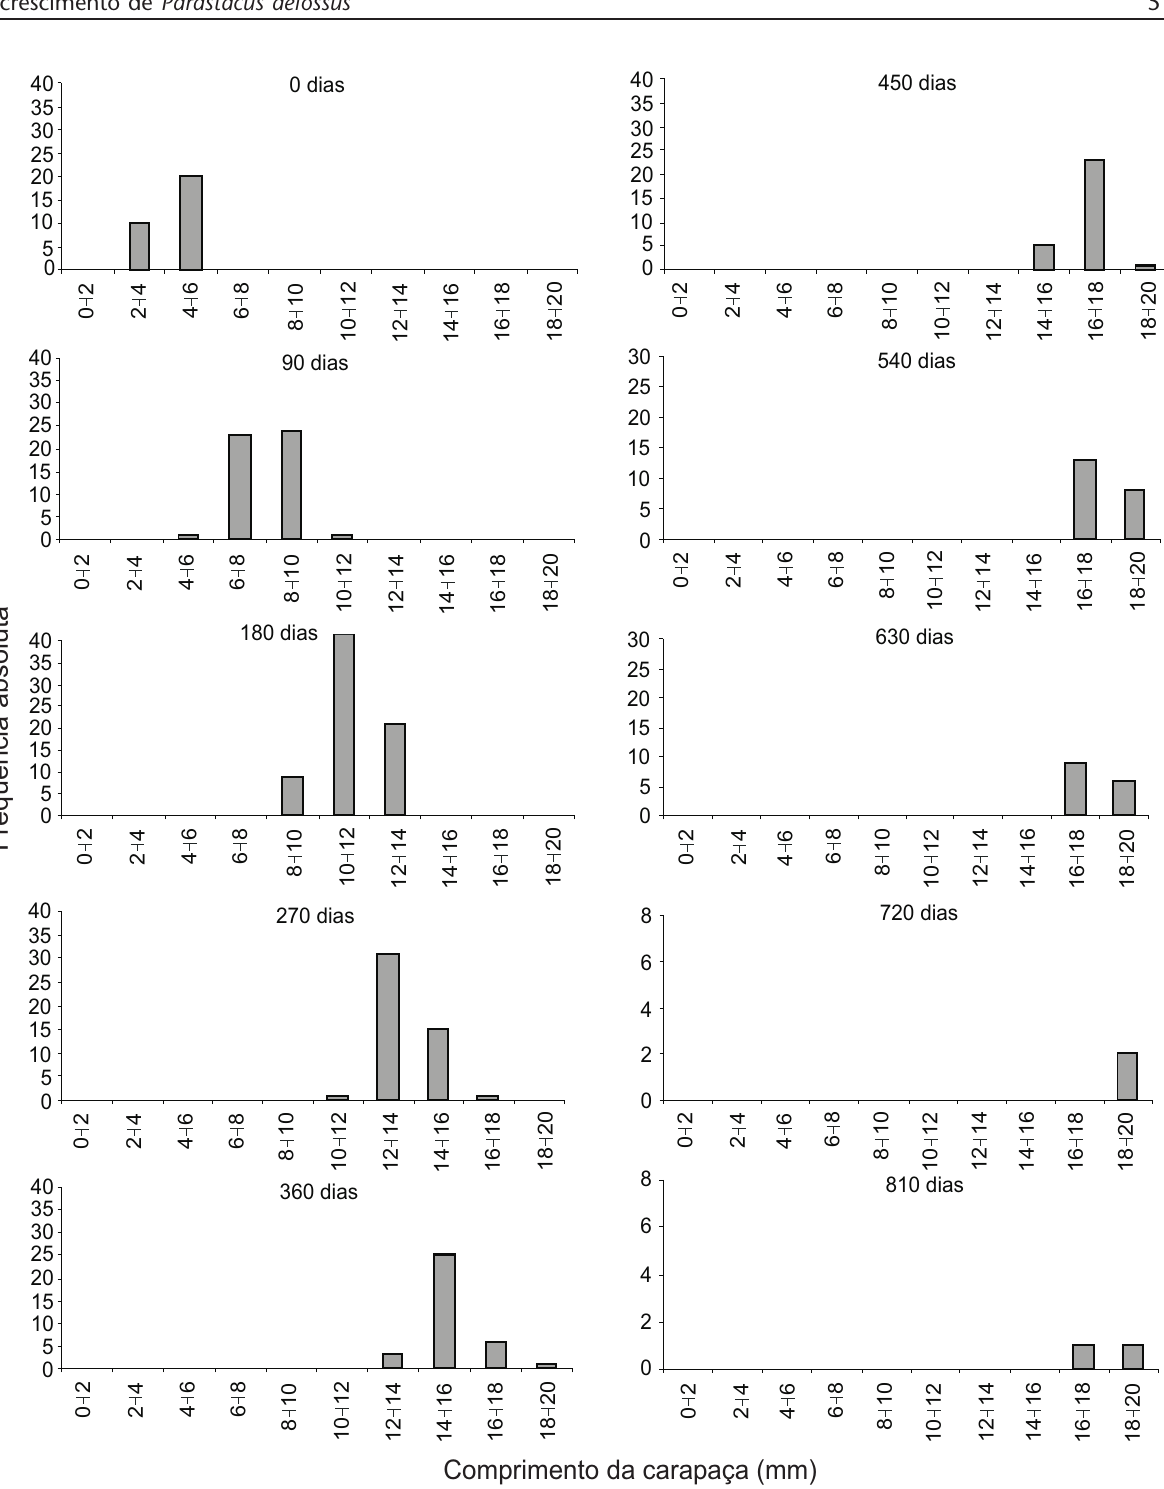
Figura 2. Distribuição das freqüências absolutas trimestrais do comprimento da carapaça (mm) dos juvenis de P. defossus , cultivados em laboratório no período de dezembro de 2003 a fevereiro de